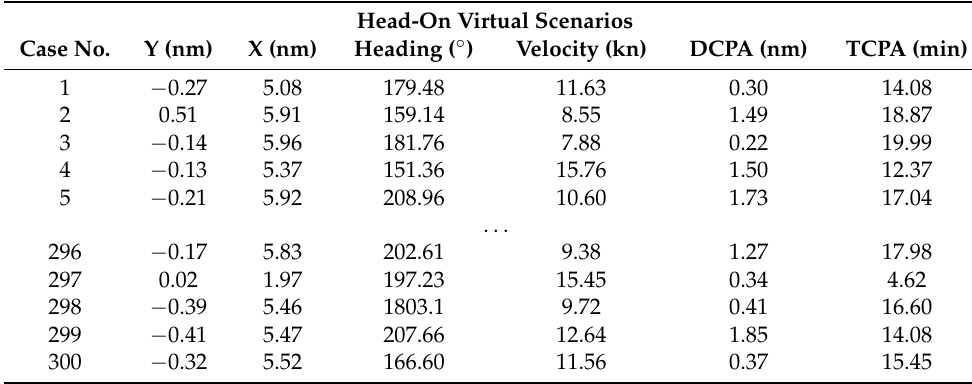
Table 4. The virtual scenarios generated for head-on encounter.